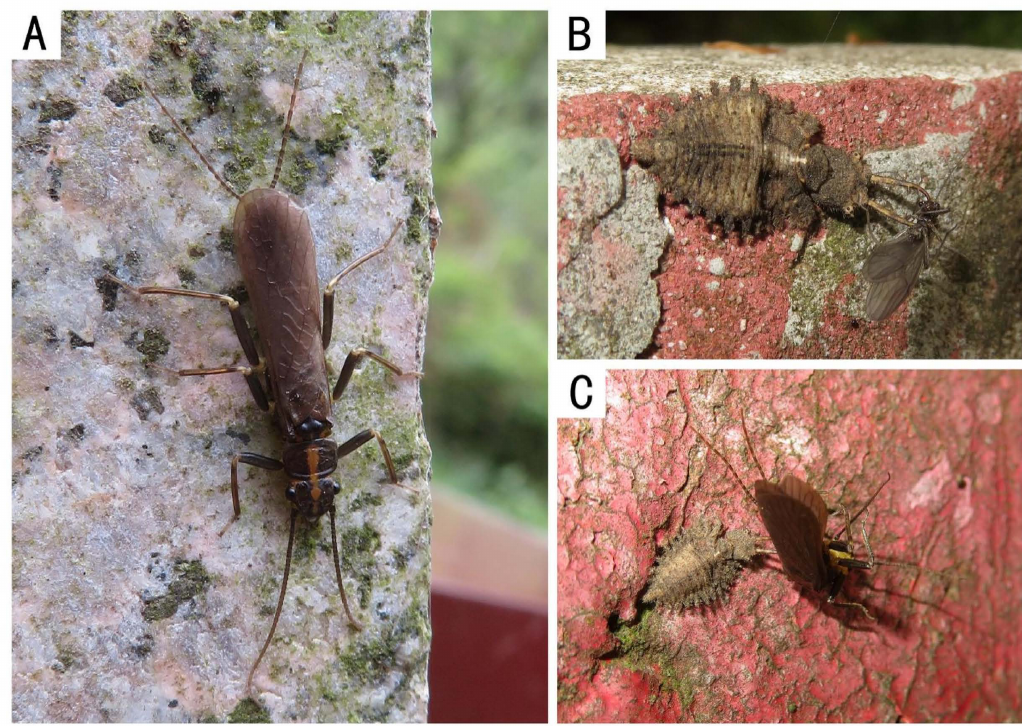
Figure 6. Filchneria songi . ( A ) male on the stone bridge; ( B , C ) the larvae of Ascalaphidae which were hunting Nemouridae sp. and F. songi on the nearby bridge.